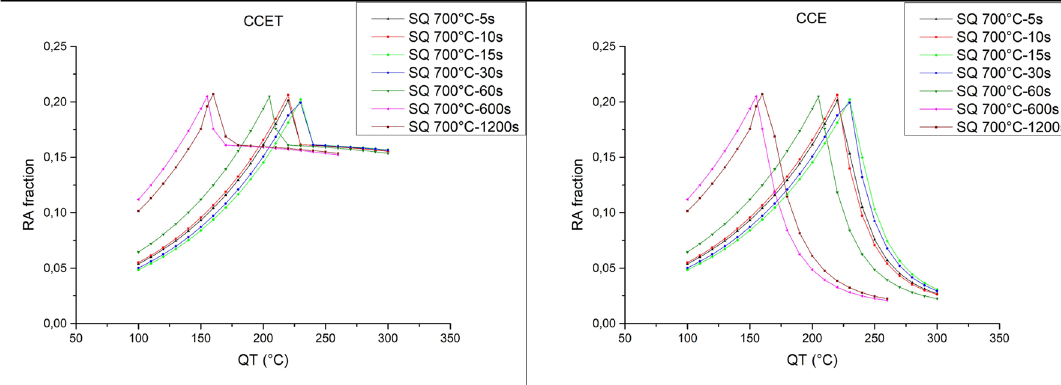
Figure 8. Partial quenching temperature (QT) as a retained austenite final fraction function predicted by the thermodynamic models CCE and CCET from the application of Q&P cycles in microstructures previously treated in different SQ cycles. Partitioning temperature equal to